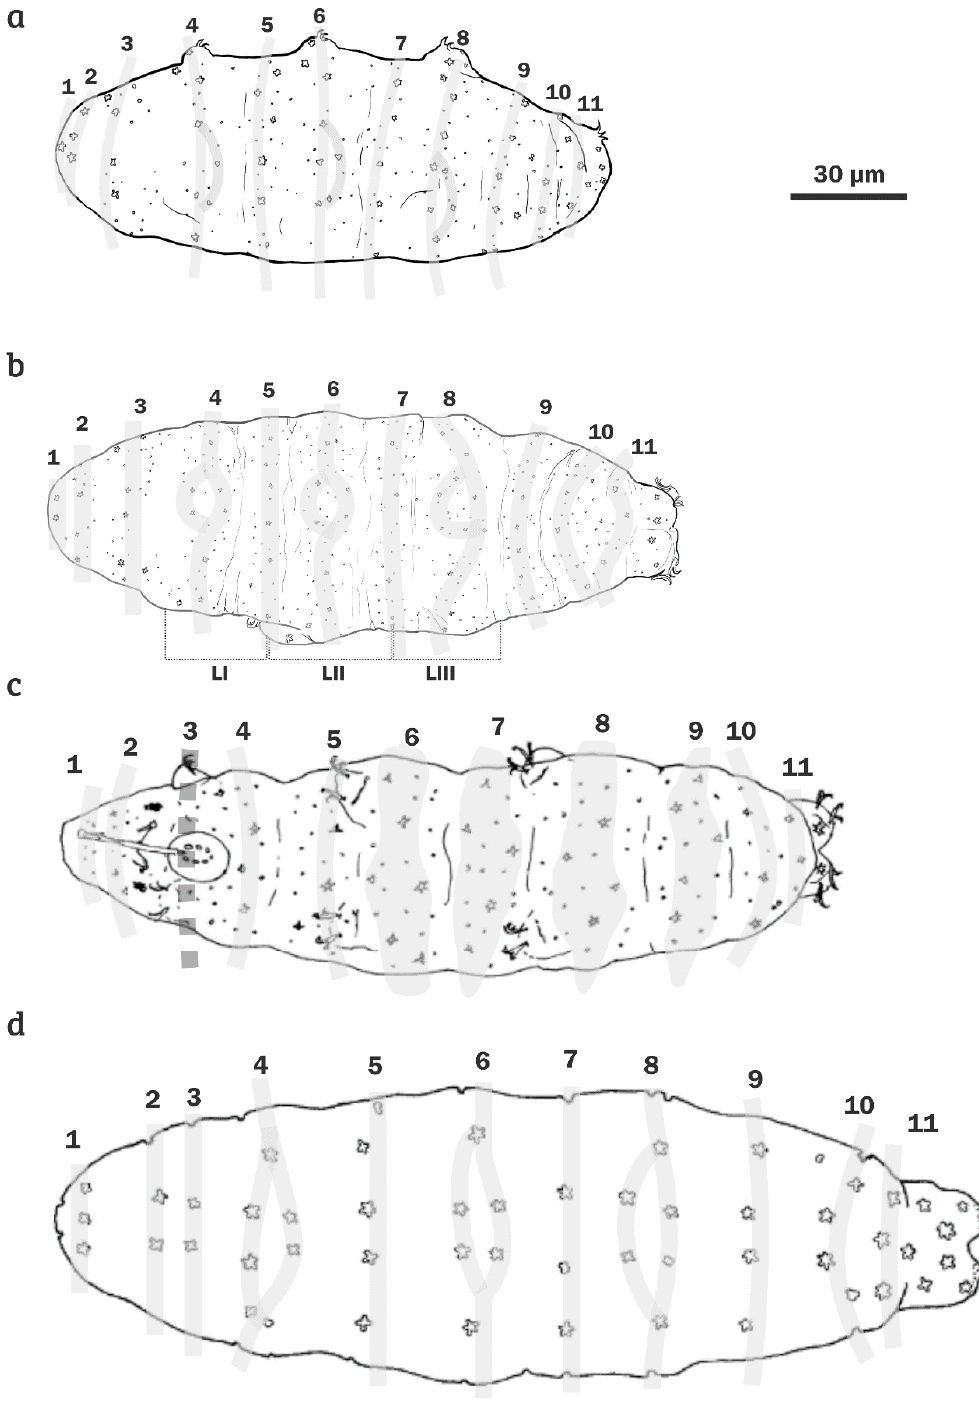
Figure 9. A semi-schematic drawing of a dorsal positioned animal showing a pattern of the dorsal cuticle of star-shaped pores arranged in 11 transverse rows (Arabic numbers), which become double in the segments of the legs I–III: ( a ) Min. citlalium sp. nov.; ( b ) Min. constellatus ; ( c ) Min. sidereus ; and ( d ) Min. pentannulatus. LI = segment of leg I, LII: segment of leg II, and LIII = segment of leg III. Stec et. al. [83] registered a population of Minibiotus pentannulatus in Tanzania; these authors add characters to those proposed by Londoño et. al. [54] for M. pentannulatus . These characters also support the differences between this species and M. citlalium sp. nov. These characters are granulation